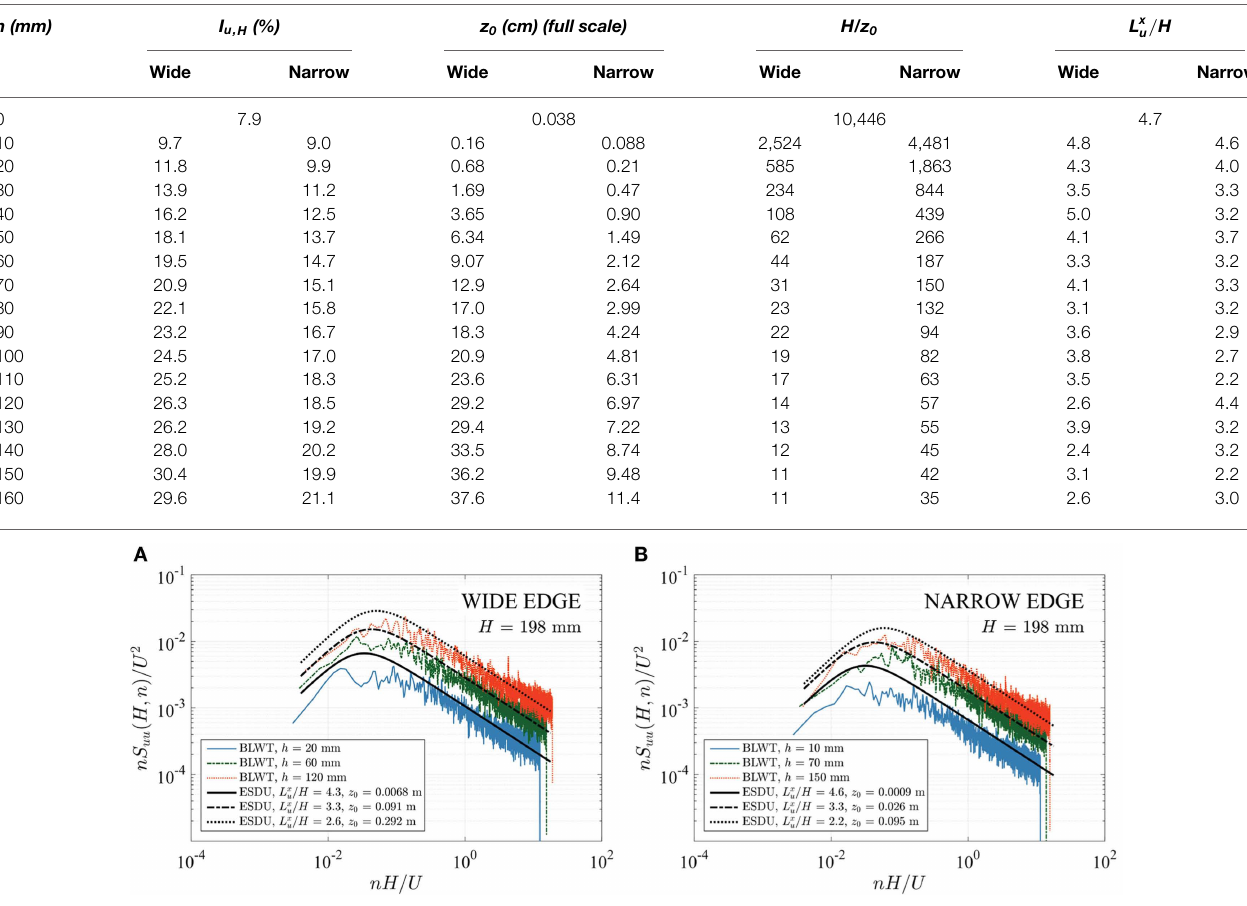
TABLE 1 | Approach flow parameters for the wide and narrow edge windward element orientations.